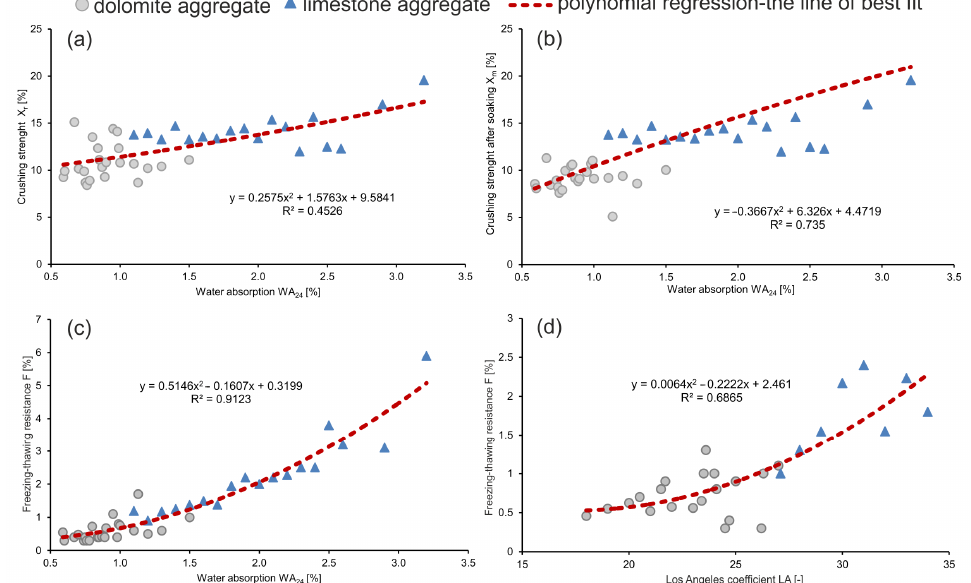
Figure 7. Relationships between geotechnical parameters for carbonate aggregates: ( a ) correlation between water absorption WA 24 and crushing strength X r ; ( b ) correlation between water absorption WA 24 and crushing strength after soaking X m ; ( c ) correlation between water absorption WA 24 and freezing-thawing resistance F; ( d ) correlation between Los Angeles coefficient LA–resistance to fragmentation and freezing–thawing resistance